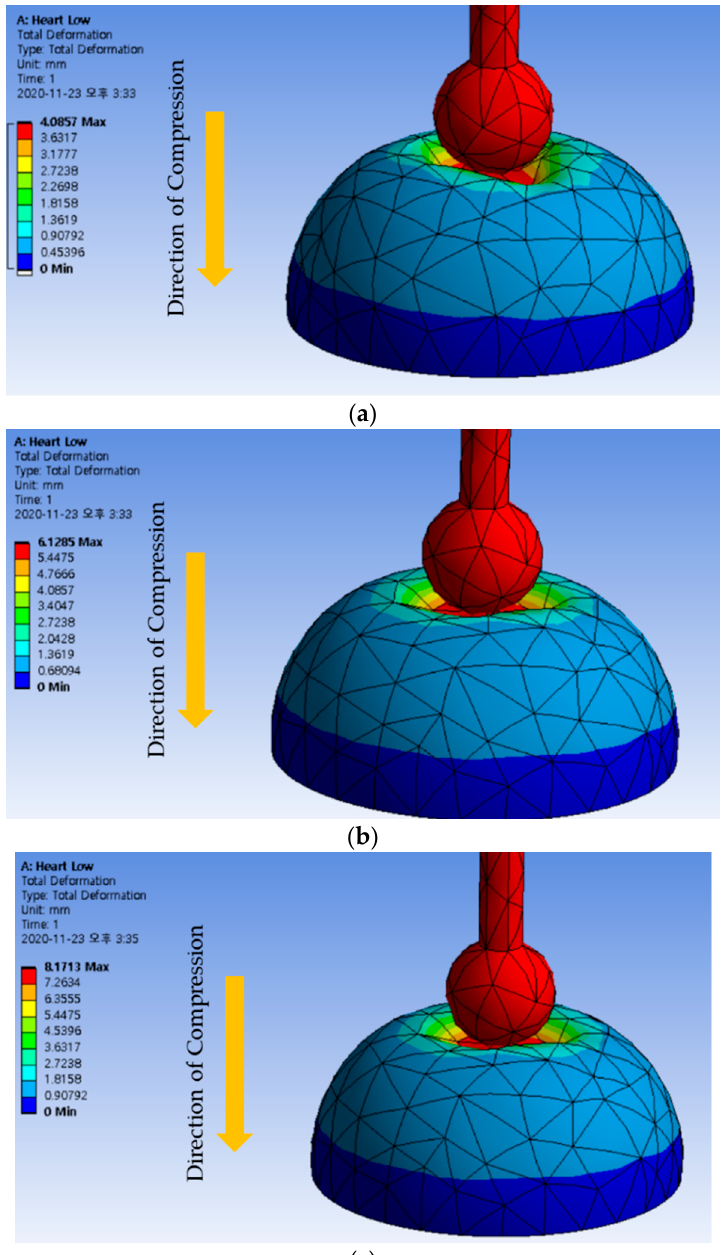
Figure 10. FEM analysis results according to compressive deformation depth ( a ) 4 mm compression. ( b ) 6 mm compression ( c ) 8 mm compression. Table 2. Maximum repulsive force using the finite element method (calculated).